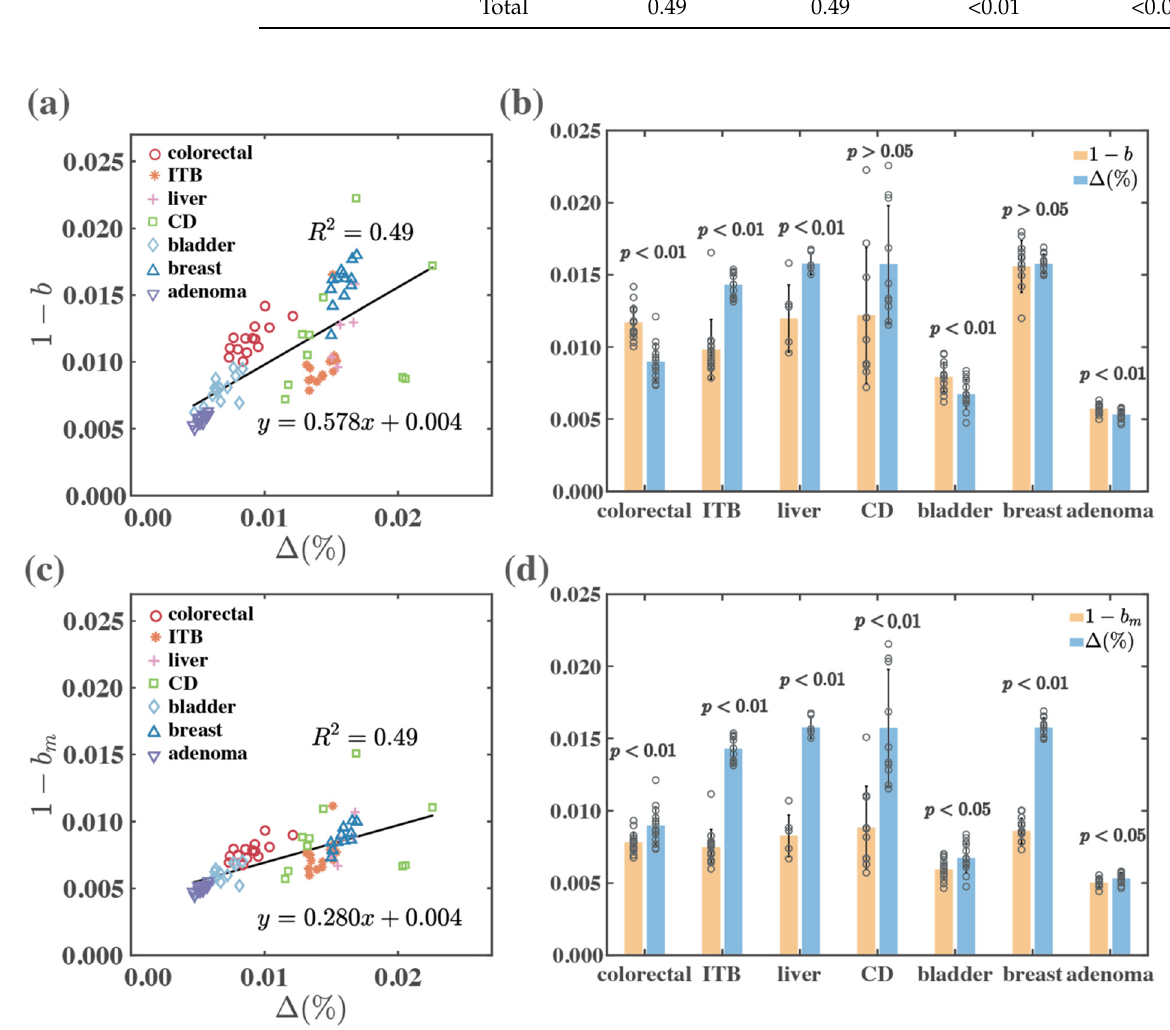
Figure 7. Comparison of MMT and MMPD depolarization parameters of thin tissue samples. ( a ) Depolarization MMPD parameter Δ plotted against its counterpart MMT parameter 1 − b for correlation analysis with all seven kinds of thin tissue samples. ( b ) Statistical analysis bar chart of depolarization MMPD parameter Δ and MMT parameter 1 − b for each kind of thin tissue samples. ( c ) Depolarization MMPD parameter Δ plotted against its counterpart MMT parameter 1 − b m for correlation analysis with all seven kinds of thin tissue samples. ( d ) Statistical analysis bar chart of depolarization MMPD parameter Δ and MMT parameter 1 − b m for each kind of thin tissue sample.